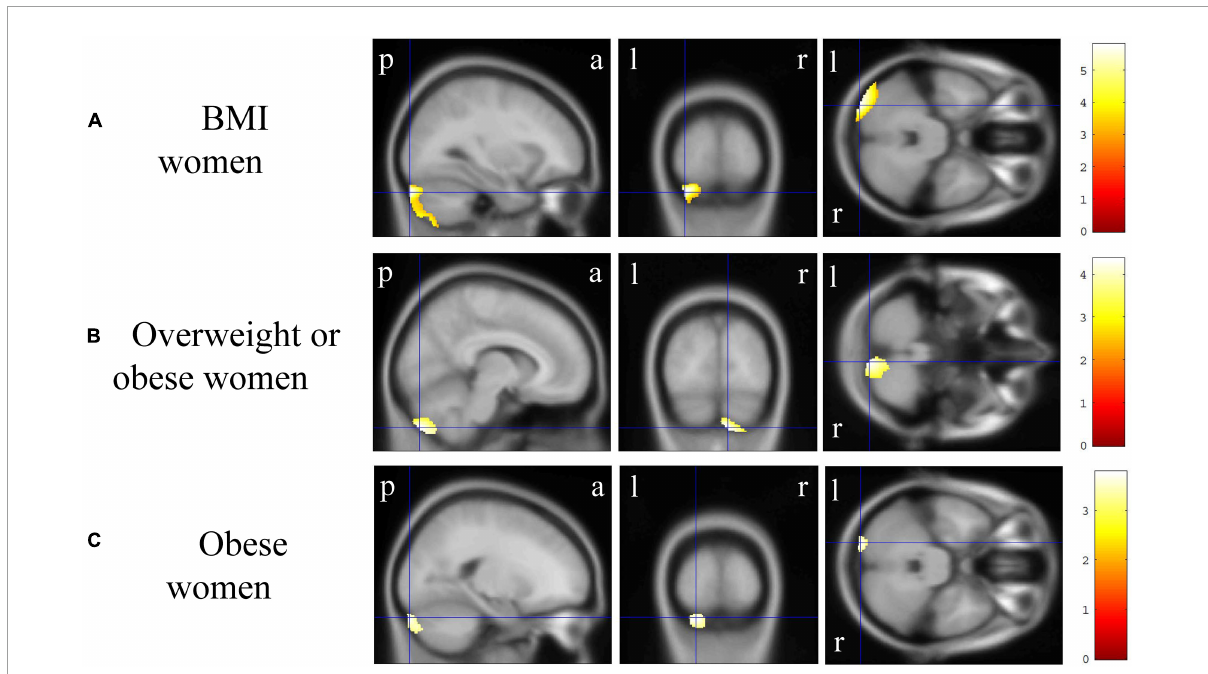
FIGURE4 Gray matter regions where the volume was associated with body mass index (BMI), overweight or obese, and obese women. (A) BMI was negatively correlated with gray matter volumes in the bilateral cerebellum exterior [ p < 0.01 corrected, Montreal Neurological Institute (MNI) 152 T1 atlas coordinates: x = − 30.0 mm, y = − 93.0 mm, z = − 31.5 mm indicated by blue cross-hair lines]. (B) Gray matter volume in the right cerebellum exterior was reduced in overweight or obese women when compared with that in underweight or normal men ( p < 0.05 corrected, MNI 152 T1 atlas coordinates: x = 9.0 mm, y = − 84.0 mm, z = − 51.0 mm indicated by blue cross-hair lines). (C) Gray matter volume in the left cerebellum exterior was reduced in obese women when compared with that in non-obese women ( p < 0.01 corrected, MNI 152 T1 atlas